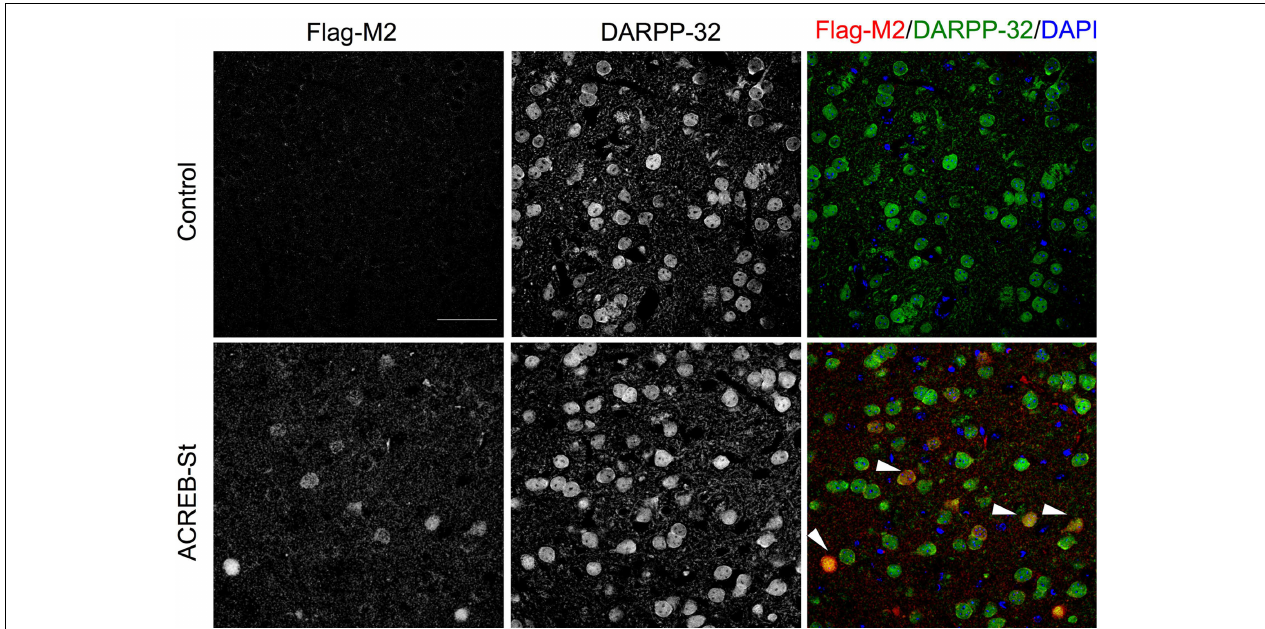
FIGURE 3 | Expression of A-CREB protein and colocalization with a marker for interneurons. Double immunostaining using antibodies against Flag-M2, which recognizes A-CREB, and DARPP-32. The colocalization of both markers demonstrates that the transgene is expressed in striatal GABAergic medium